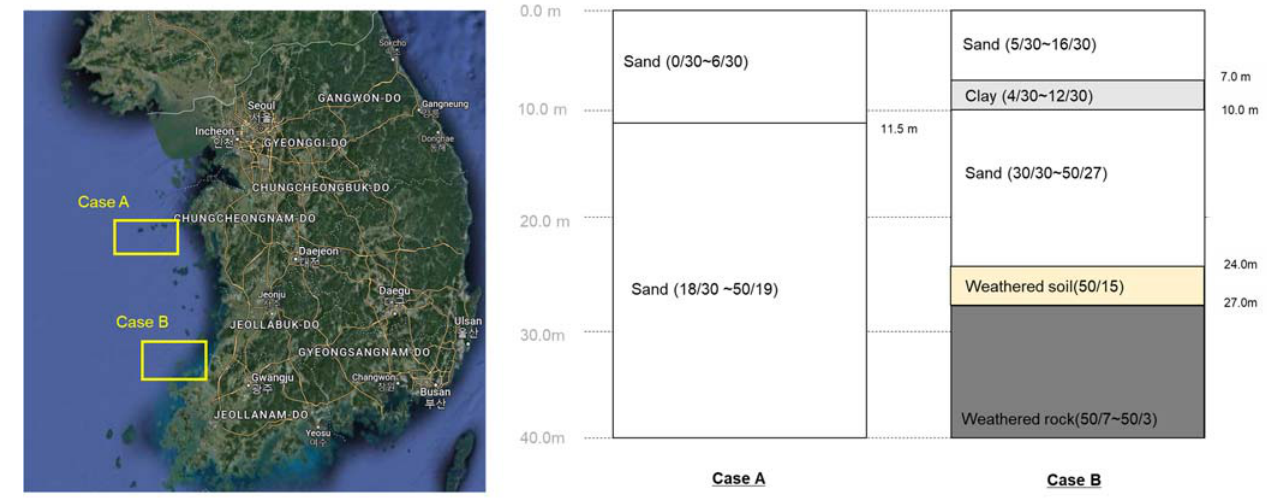
Figure 12. Target sites and its soil layer composition. Table 5. Soil layer and input parameters